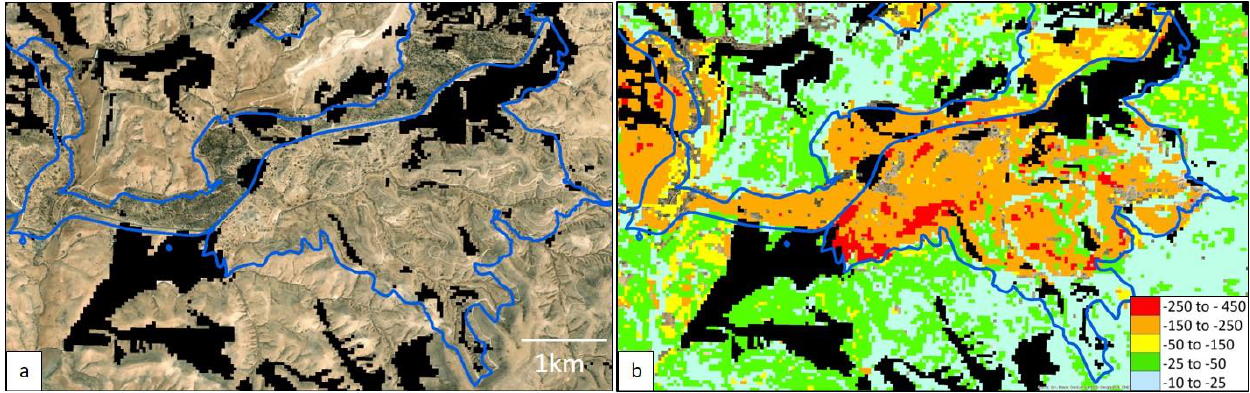
Figure 12. Savannization—areas enclosed in blue lines. 1 km S of Afeinish (31°18.46′ N, 35°0.18′ E). ( a ) True color image; ( b ) LNS diff (gC m −2 yr −1 ).